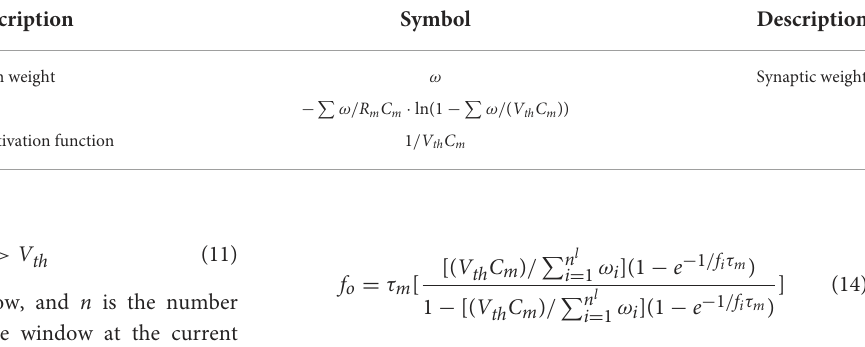
TABLE 1 Parameter mapping between ReLU-AN model and Linear LIF model. Parameter of ReLU Params of linear LIF Symbol Description Symbol Description Connection